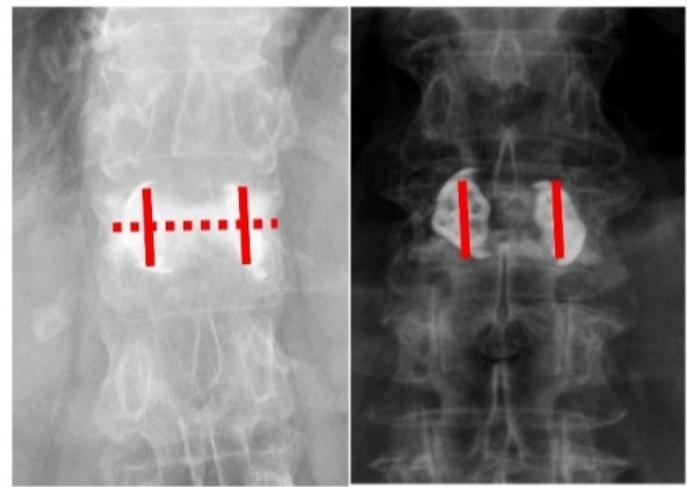
Figure 2. ( Left ) The AP view of the radiographic image shows a positive double cross sign. The bone cement expands vertically along the bilateral SpineJack system, and across the midline of the vertebral body. ( Right ) The AP view of the radiographic image shows a negative double cross sign. The bone cement expands vertically along the bilateral SpineJack system without spreading across the midline of the vertebral body.